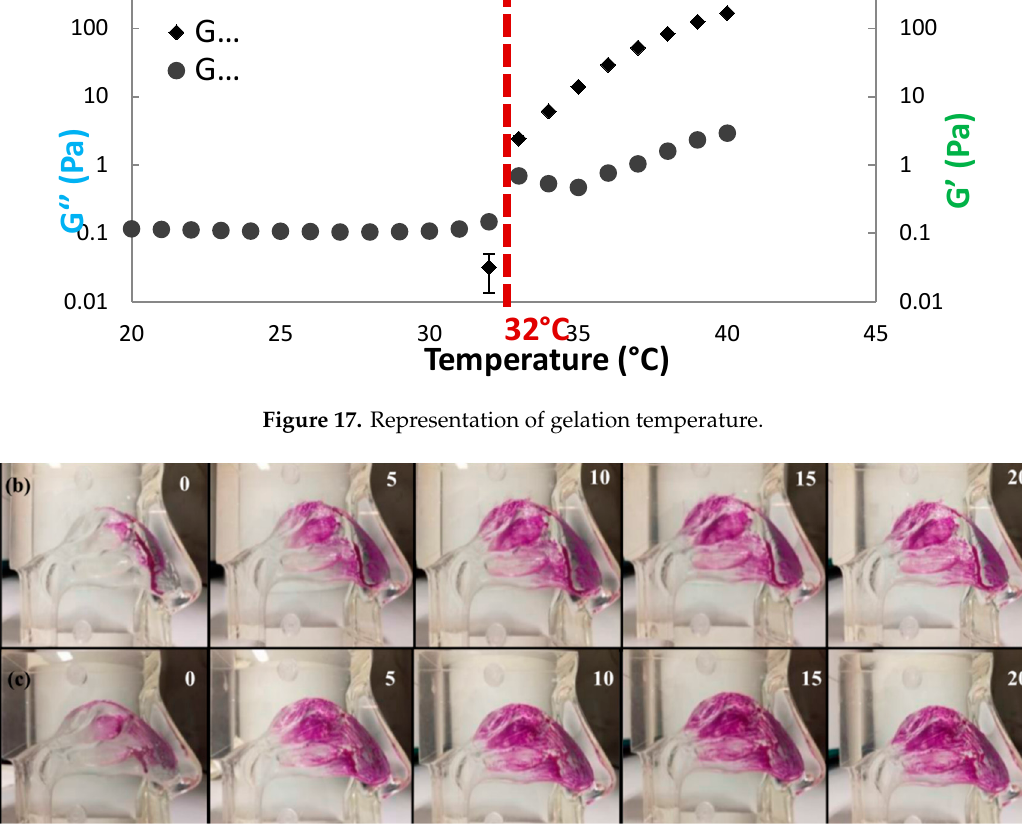
Figure 18. The gelation of the formulation ( b ) on the nasal surface (human nasal model) occurred in 5 min at 37 °C and stopped nasal run off, and the deposition pattern on the wall of the nasal cast cavity remained unchanged from 5 to 20 min. In contrast, control continued to show leakage ( c ). The aerodynamic particle size distribution (about 90% >10 µm) was consistent with nasal deposition.